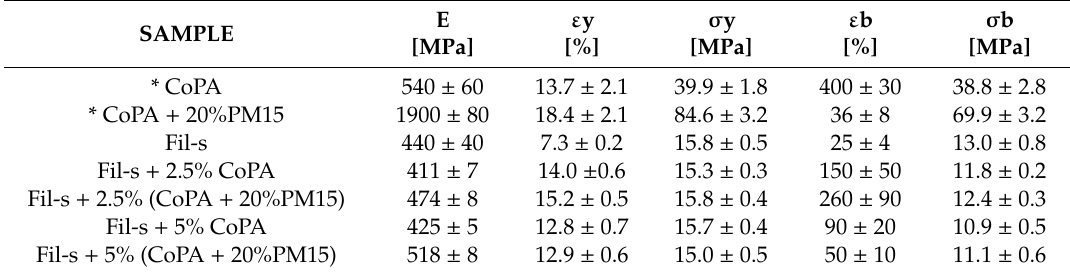
Table 7. Principal tensile mechanical properties of the ribbons made of the neat copolyamide, copolyamide masterbatch, Fil-s, and their blends.